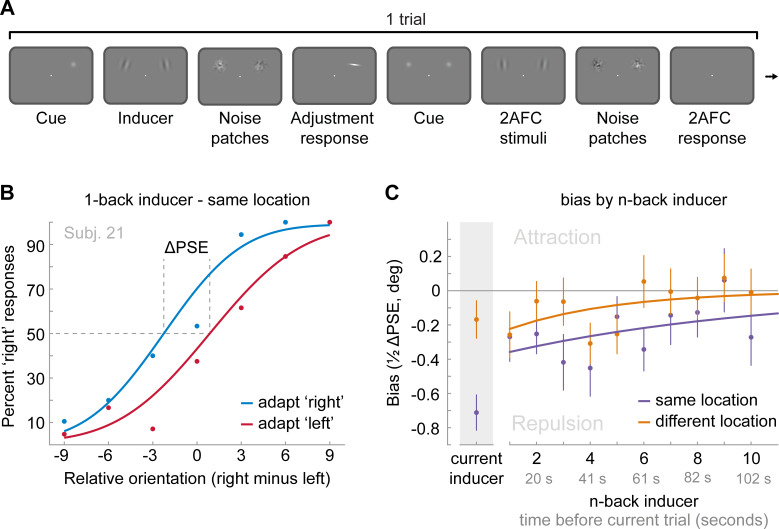
Task and results of Experiment 4: The long-term stimulus history directly biases the perceived orientation of current stimuli.(A) Observers were cued to reproduce one of two Gabor stimuli by adjusting a response bar (adjustment response). Subsequently, two new Gabor stimuli appeared at priorly cued locations in the left and right visual field. Those stimuli could appear either at the same locations as the previous stimuli or 10 visual degrees above or below. Observers had to judge which of the two new stimuli was oriented more clockwise (2AFC). Similar to the previous experiments, all Gabor stimuli were followed by noise masks. (B) Psychometric curves for the 2AFC judgments of one example observer. We expressed the probability of a ‘right’ response (y-axis) as a function of the orientation difference between right and left 2AFC stimuli (x-axis). For positive x-values, the right stimulus was oriented more clockwise. We binned the trials in two bins according to the expected influence of repulsive adaptation to the inducer stimulus. Blue data points represent trials in which repulsive adaptation, away from the inducer, would favor a ‘right’ response, while red data points represent trials in which it would favor a ‘left’ response. The example observer exhibits a repulsive adaptation bias. We quantified the magnitude of the bias as the difference in the points of subjective equality between ‘adapt right’ and ‘adapt left’ curves (ΔPSE) divided in half. This value indicates how much a 2AFC stimulus is biased by a single inducer stimulus. (C) Bias exerted by the current inducer (gray shaded box, same data as in Experiment 2 by Fritsche et al., 2017) and inducers of the 10 preceding trials. Previous inducer stimuli exert a repulsive bias on the current 2AFC stimuli, specifically when past inducer and current 2AFC stimuli were presented at an overlapping spatial location. This bias appears to decay exponentially for inducers encountered further in the past. Note that while current inducers were always oriented ±20° from the subsequent 2AFC stimulus, constituting an optimal orientation difference for eliciting adaptation biases (e.g. see Figure 2B), relative orientations of previous inducers ranged from −49 to 49°, and thus presented overall less effective adaptor stimuli. This may explain the discontinuity in the magnitude of repulsion exerted by the current and previous trial inducer. Data points show group averages and error bars present SEMs.Figure 5—source data 1.Task and results of Experiment 4: The long-term stimulus history directly biases the perceived orientation of current stimuli.The source data file contains two csv files with estimated biases exerted by the previous 10 inducer stimuli, when the inducer was presented at the same or different spatial location, respectively (participants x n-back inducer).